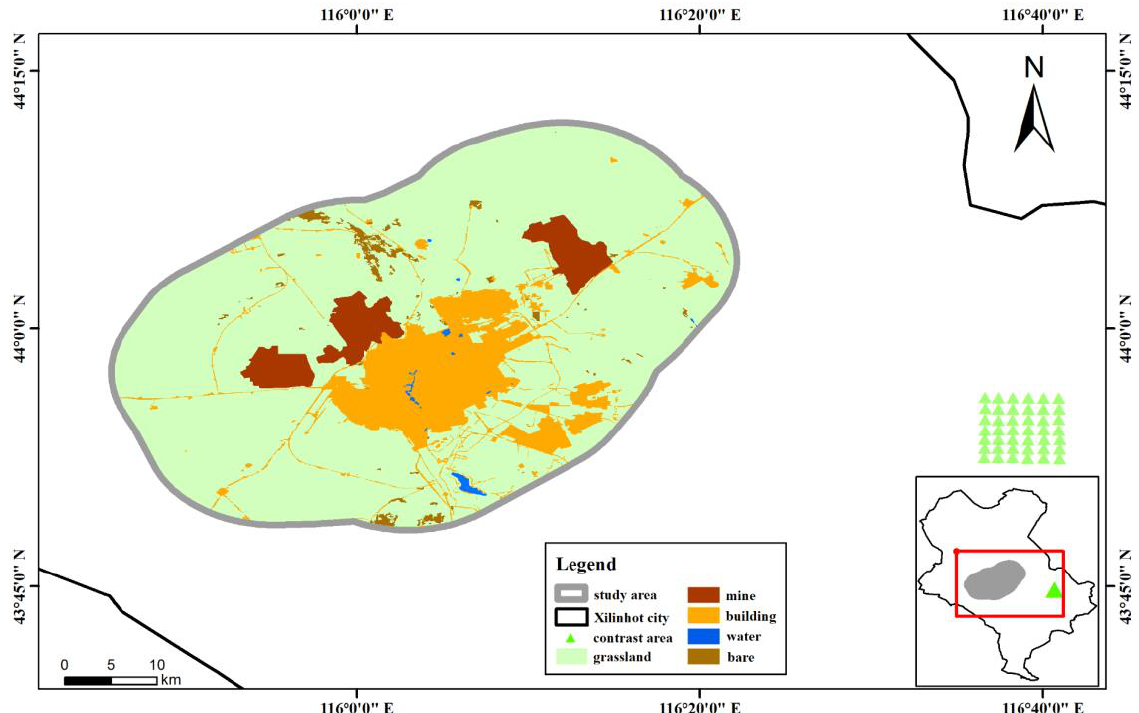
Figure 3. Map of the contrast area.